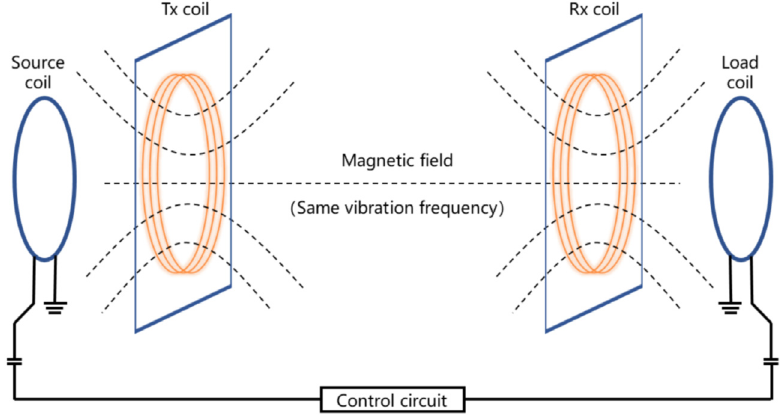
Fig. 1. WPT system